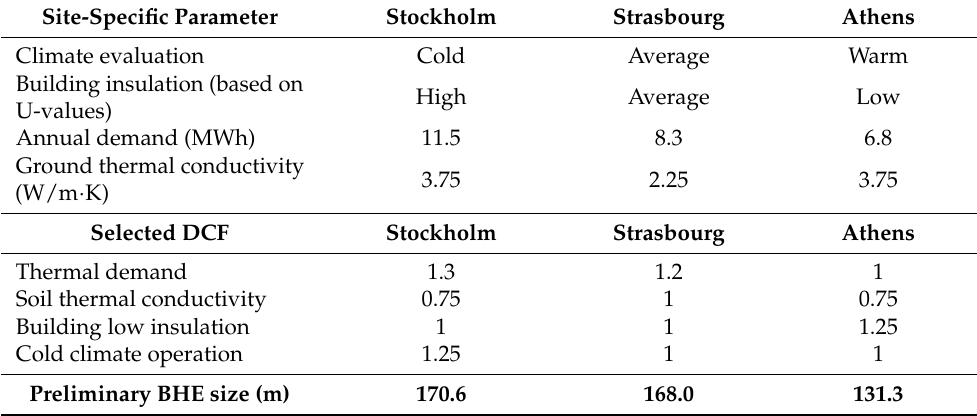
Table 6. Site-specific parameters and the selected design correction factors